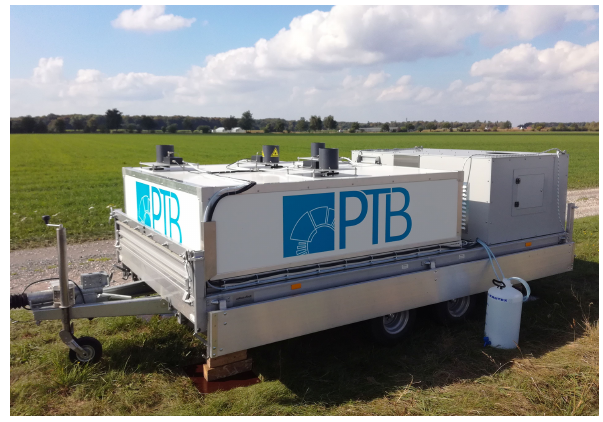
Figure 2. Photograph of the bistatic PTB lidar at the measurement site (opened trailer